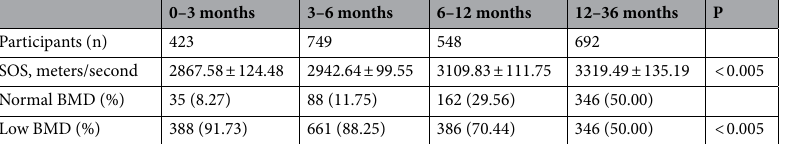
Table 2. Comparison of speed of sound and bone mineral density in different age groups. Categorical variables are shown as average (percentage). Continuous variables are shown as mean ± standard deviation. n number, BMD bone mineral density, SOS speed of